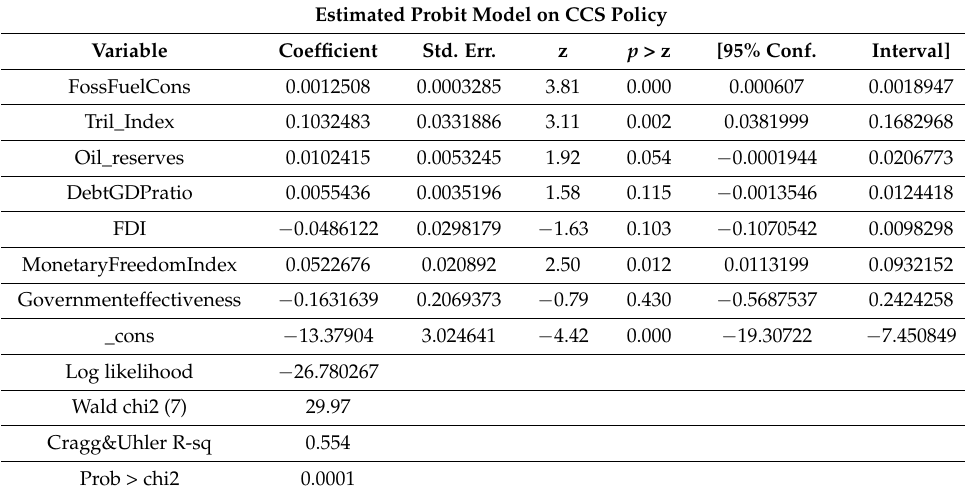
Table 5. Binary probit model 2 results.